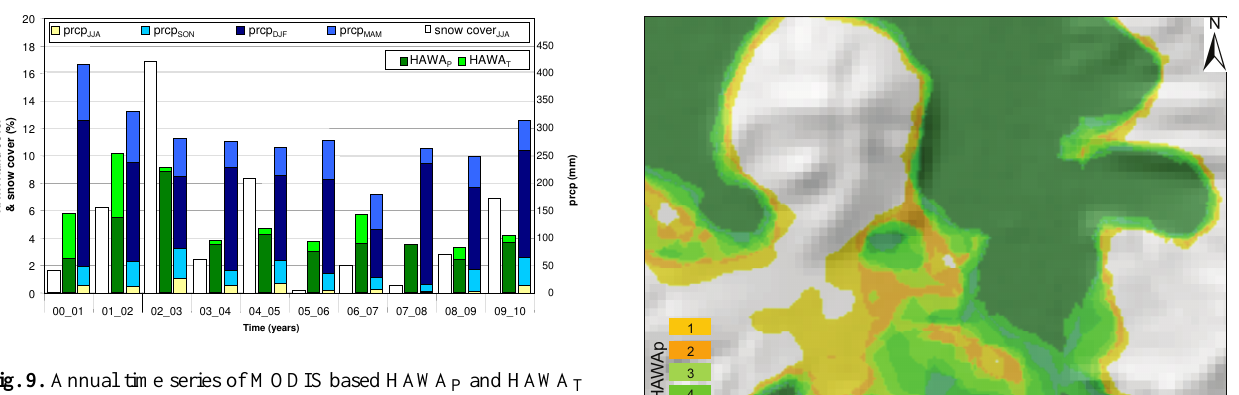
Fig. 9. Annual time series of MODIS based HAWA P and HAWA T land cover, three-monthly precipitation (mm) derived from monthly rain rate of TRMM (3B43) from 1 June 2000 to 31 May 2001 (00 01) till 1 June 2009 to 31 May 2010 (09 10) and average three- monthly (JJA) snow cover (JJA) based on MODIS Eight Day Max- imum Snow Extend data (MOD10A2).